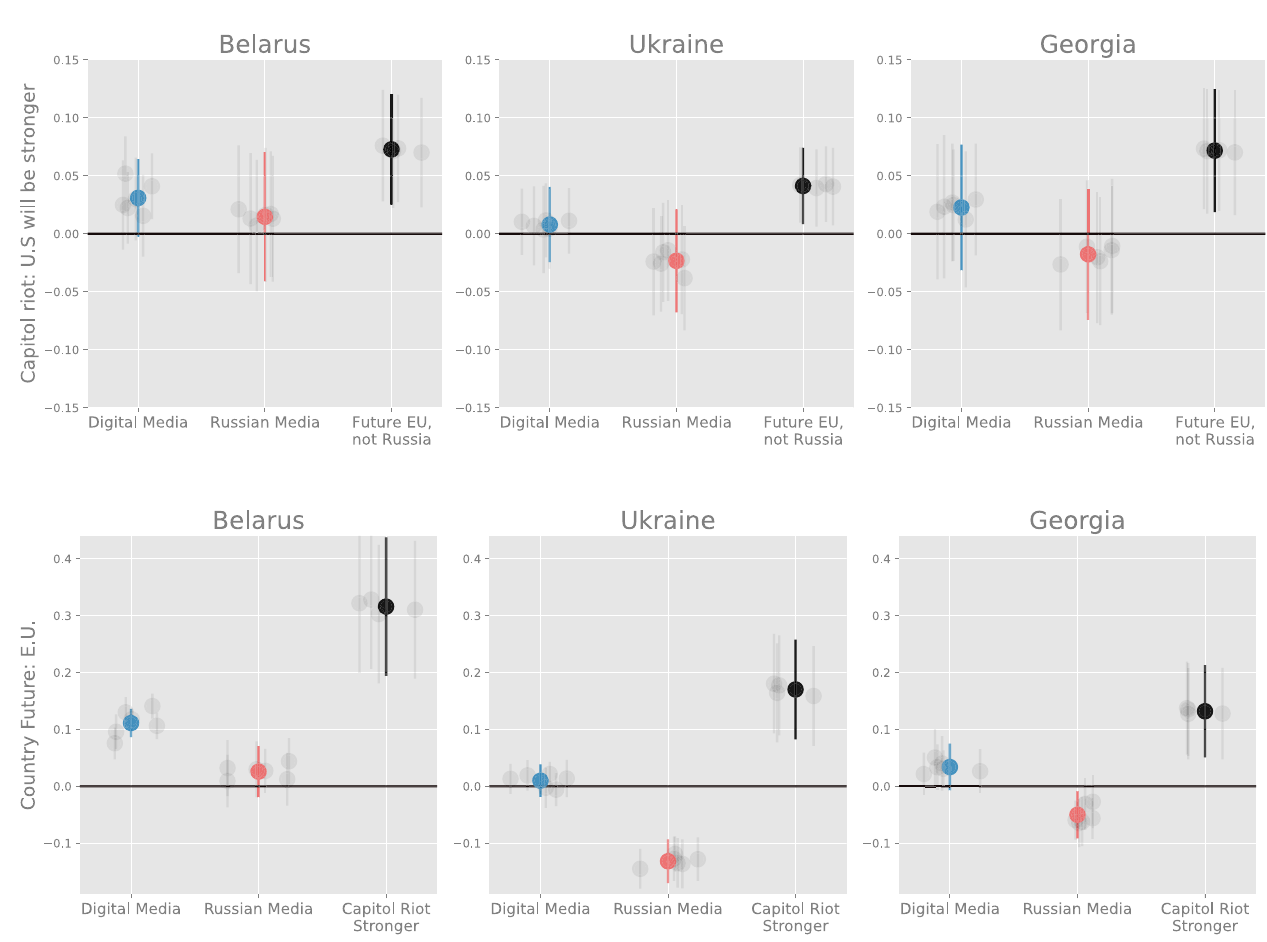
Fig. 2 Marginal effects from multivariate regressions predicting opinions about U.S. standing following the Capitol riot (top row) and prediction opinions about one ’ s country ’ s future (bottom row). The colored bars represent the average effect over multiple regression con fi gurations. The faded bars are the effects of the different model con fi gurations. See Supplementary Tables S1 – S6 for the full regression results and methods of marginal effect